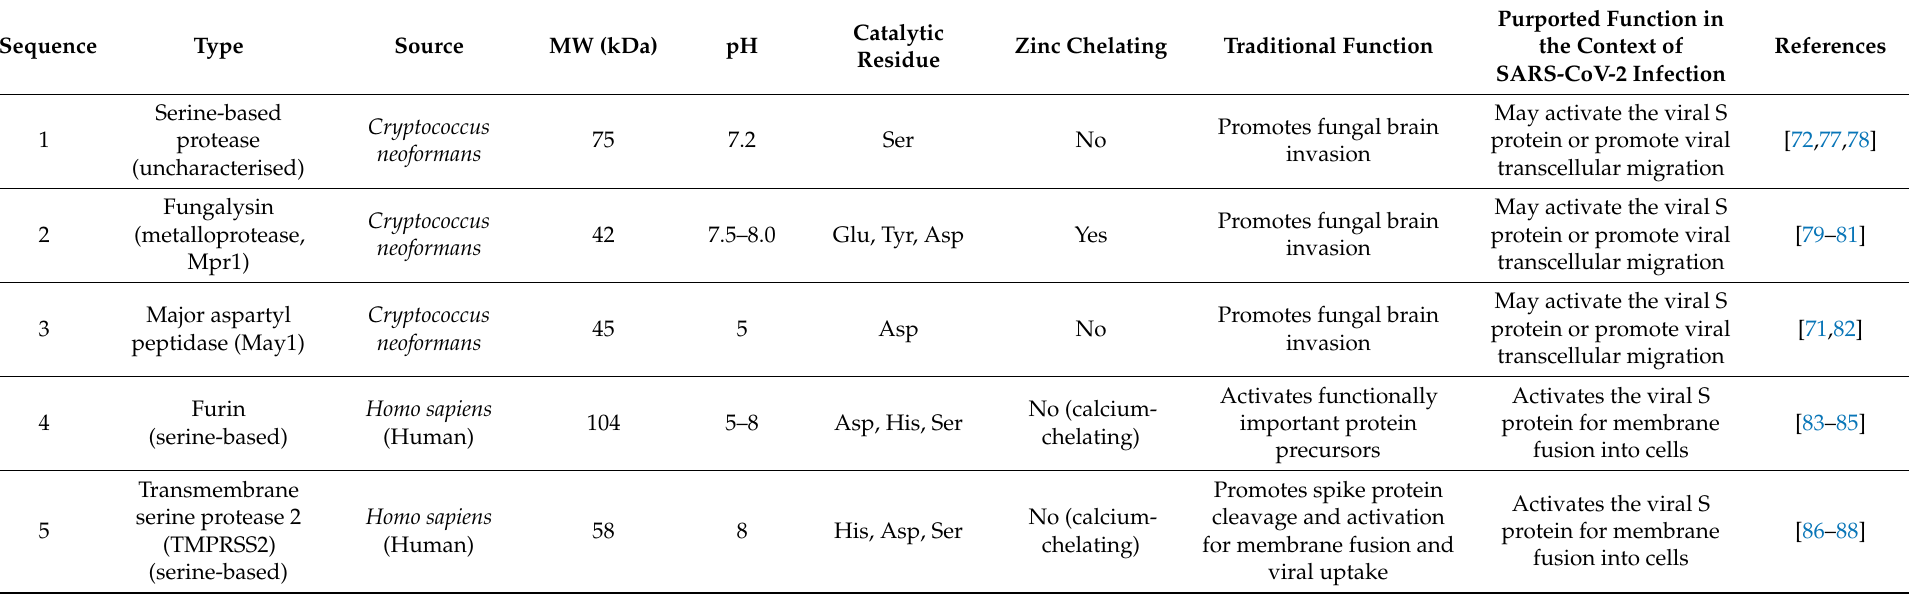
Table 2. Properties of some proteases of interest that may facilitate SARS-CoV-2 brain